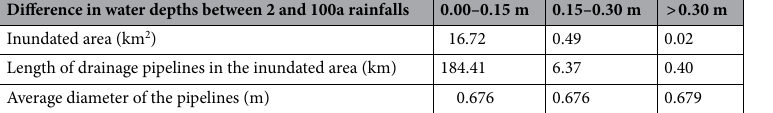
Table 5. Differences in water depth between 2 and 100a